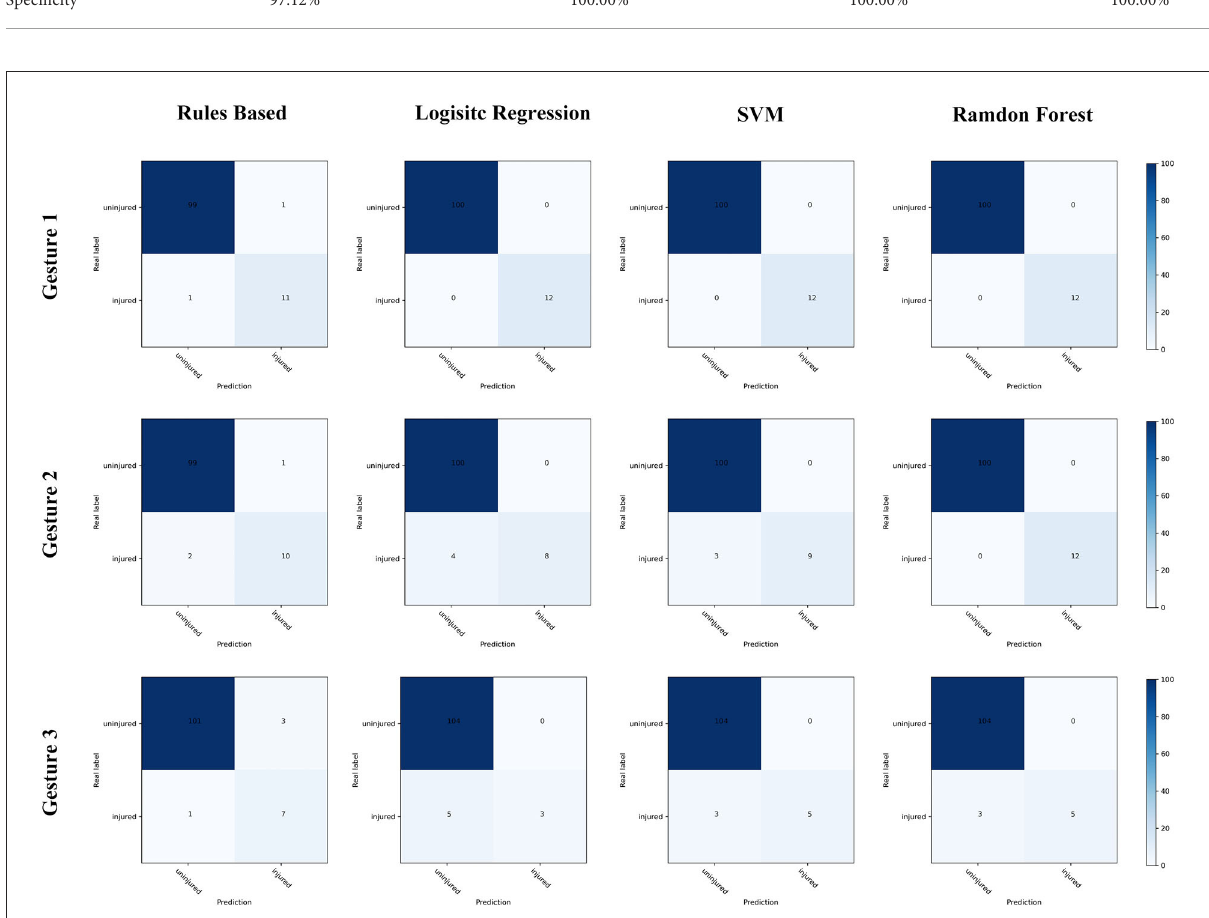
FIGURE5 The performance of all classification models, shown in confusion matrixes.